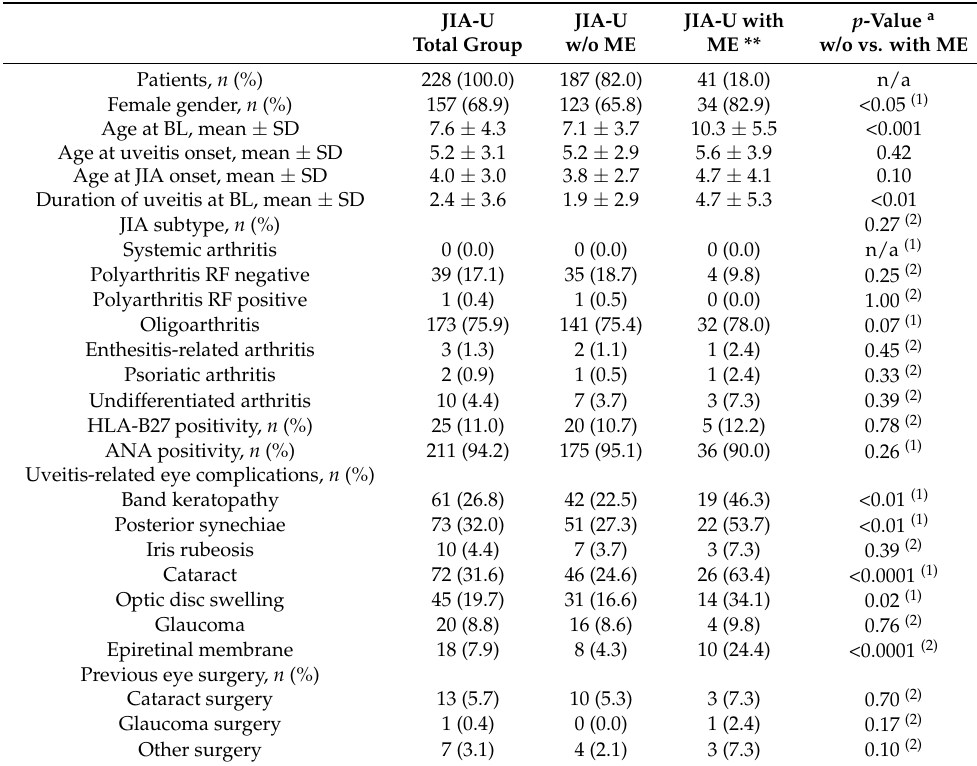
Table 1. Macular edema (ME) in patients with juvenile idiopathic arthritis-associated uveitis (JIA-U): baseline characteristics of all study